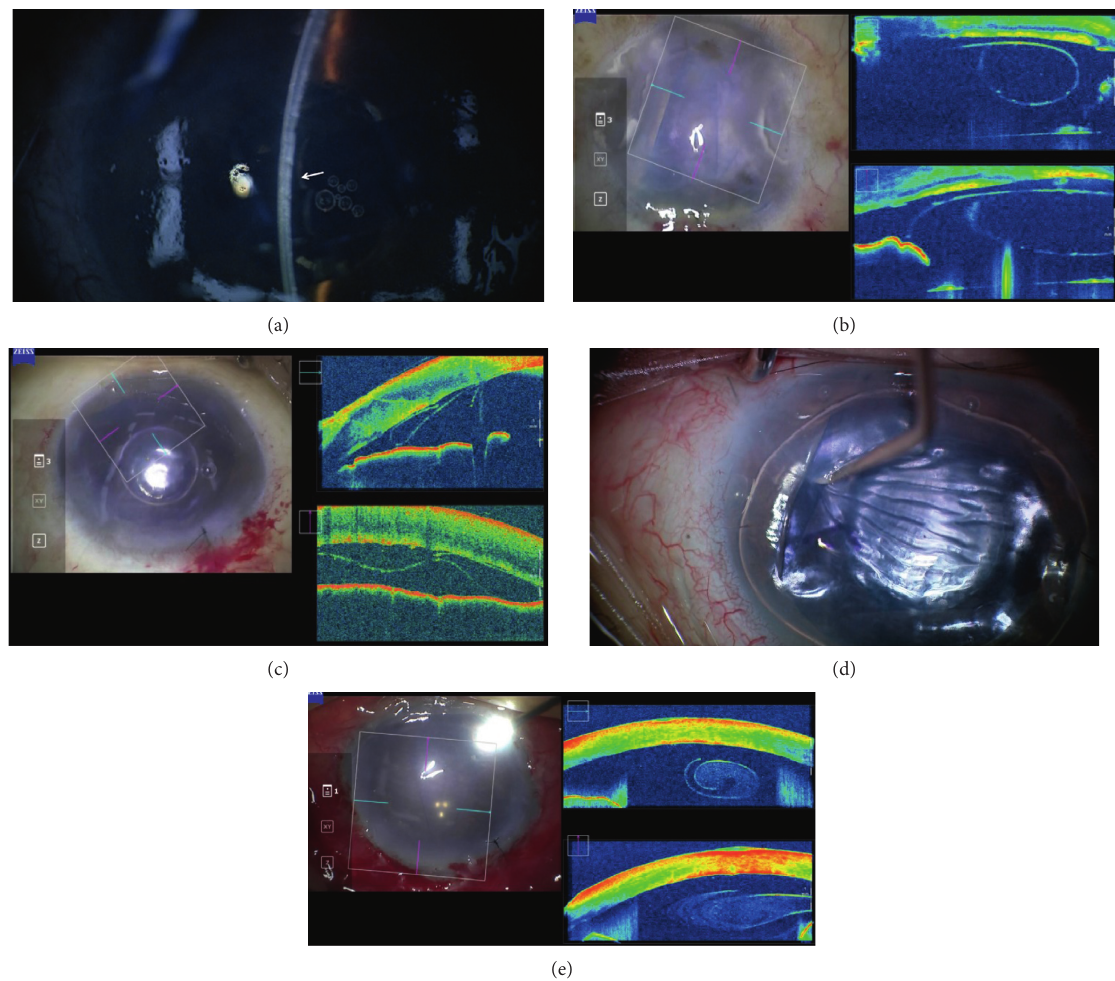
Figure 4: MIOCT images of DMEK cases. (a) Images of DMEK graft after insertion into the anterior chamber using a microscope- integrated slit-scan system. In the case of mild stromal oedema, the orientation of the DMEK graft can be ascertained (white arrow). (b) MIOCTimages of the DMEK graft insertion into the anterior chamber. The graft orientation is clearly displayed as reverse even in the case of severe stromal oedema caused by Axenfeld–Rieger syndrome. In terms of images for decision-making, MIOCTimages are much better than those of slit-scan systems. (c) Images after air injection for sticking the DMEK graft to the host cornea. The most peripheral part of the inserted DMEK graft in the anterior chamber is folded down. The MIOCT can display whether the graft folded toward the host or the anterior chamber. (d) Images of addressing the folded area by a scalpel. MIOCTimage facilitates the manoeuvre of using the scalpel from the epithelial side. (e) MIOCT images of a DMEK graft, which never opened using any manoeuvre. The graft was curled strongly. MIOCT showed cloudiness inside the curled DMEK grafts, suggestive of viscous liquid which “glued” the graft on.